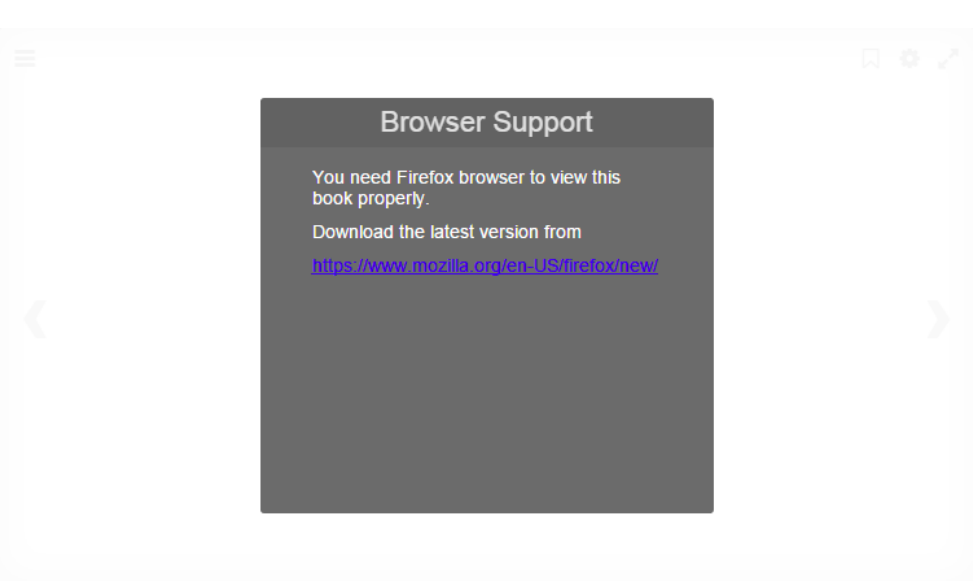
Figure 4. Required browser for offline access